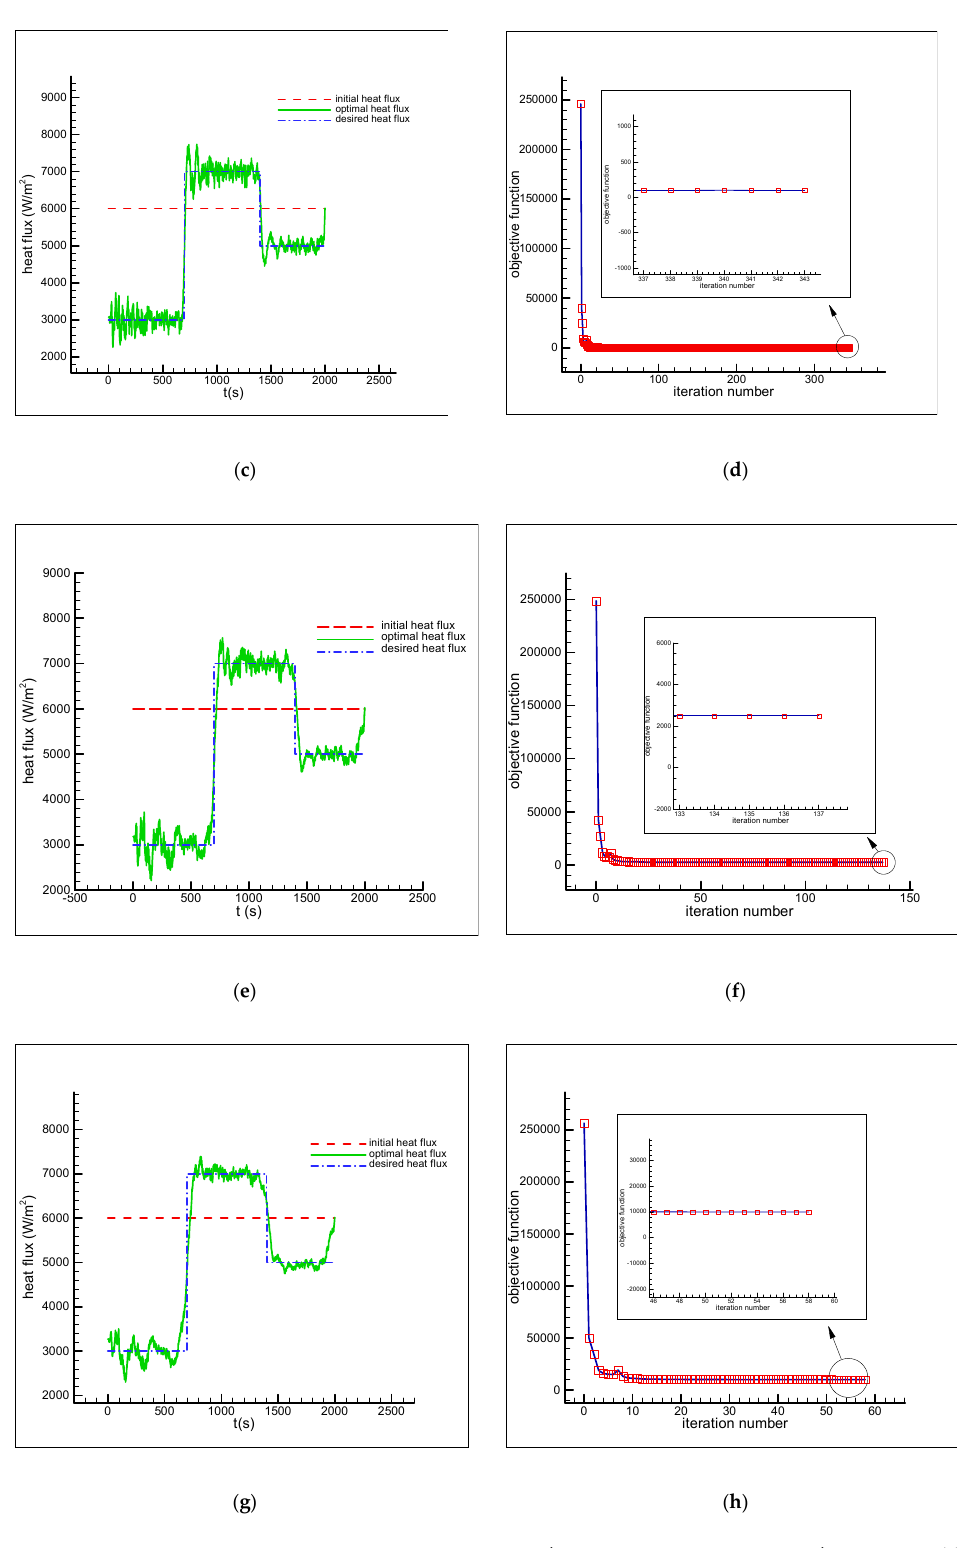
Figure 6. Estimation of the timewise varying heat flux ) and objective function versus iteration number (Test case 1) for cases of no measurement 6000.0 ( W m 2 error ( a , b ) and measurement error of σ = 0.1 ( c , d ), σ = 0.5 ( e , f ), and σ = 1.0 ( g , h ). ( a ) σ = 0; ( b ) ε = 0.5; ( c ) σ = 0.1; ( d ) ε = ( 0.1 2 ) 10000 = 100; ( e ) σ = 0.5; ( f ) ε = ( 0.5 2 ) 10000 = 2500; ( g ) σ = 1.0; ( h ) ε = ( 1.0 2 ) 10000 =